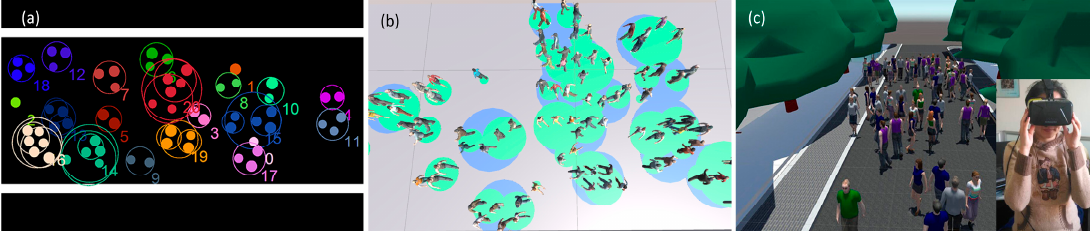
Figure 14. Participants observe the characteristics of social groups with three visualization methods. ( a ) 2D visualization (the simulation scenes are two-dimensional and pedestrians are represented as two-dimensional graphics, such as circles and triangles). ( b ) 3D visualization (the simulation scenes and pedestrians are three-dimensional models, participants can observe the movement of pedestrians on a screen). ( c ) Immersive 3D visualization (the simulation scene and pedestrians are also three-dimensional models, and participants are exposed to simulation scenes by wearing virtual reality devices).